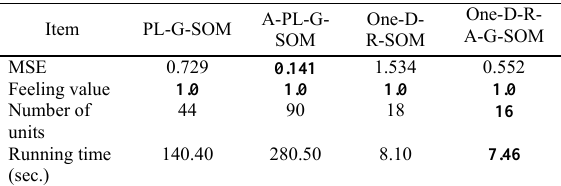
Table 3 The value of units Q t ( s t , a t ) on Action Map